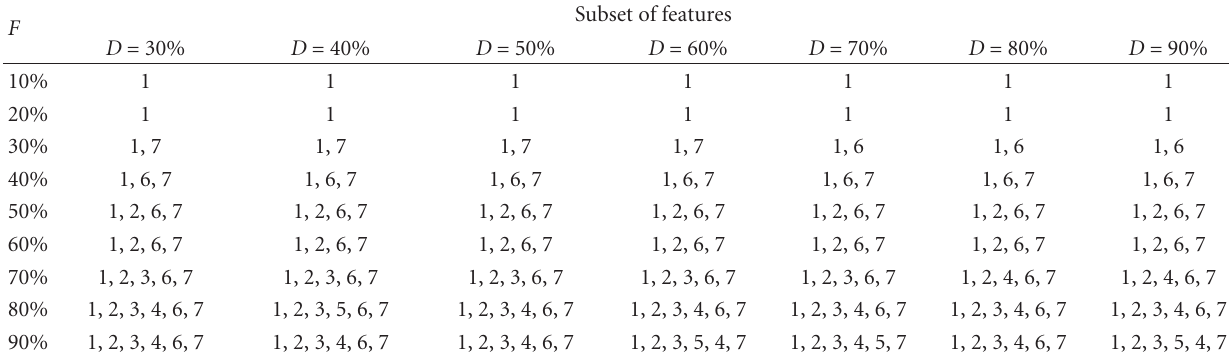
Table 8: Best subsets of features for PM10